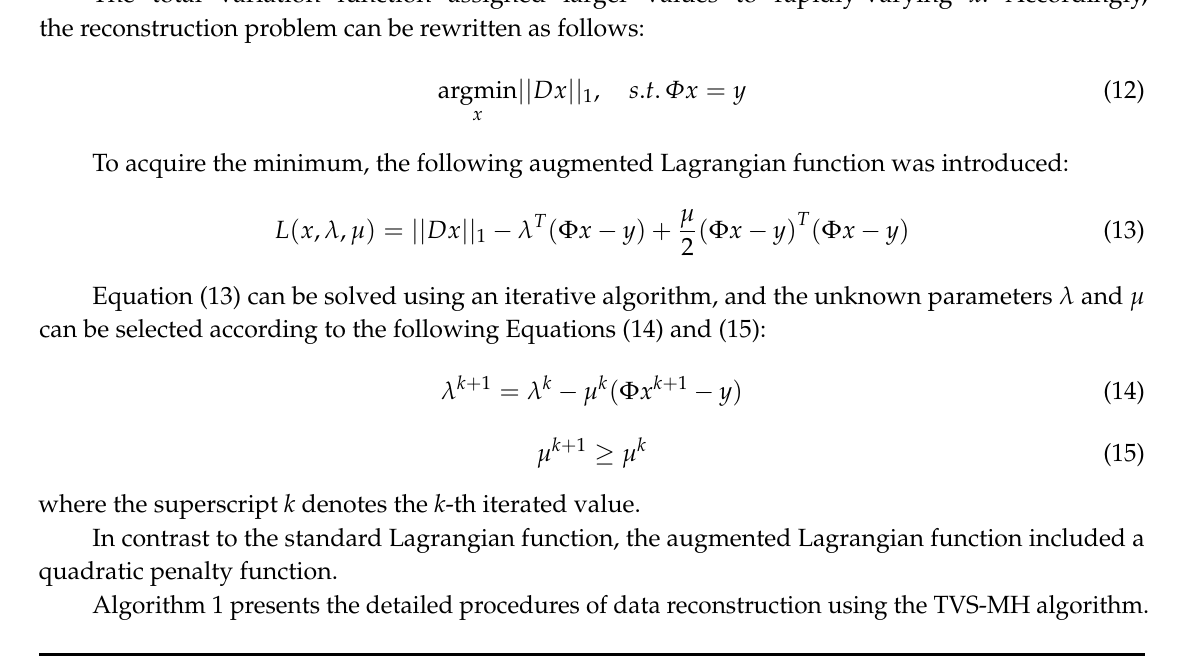
Algorithm 1. The TVS-MH